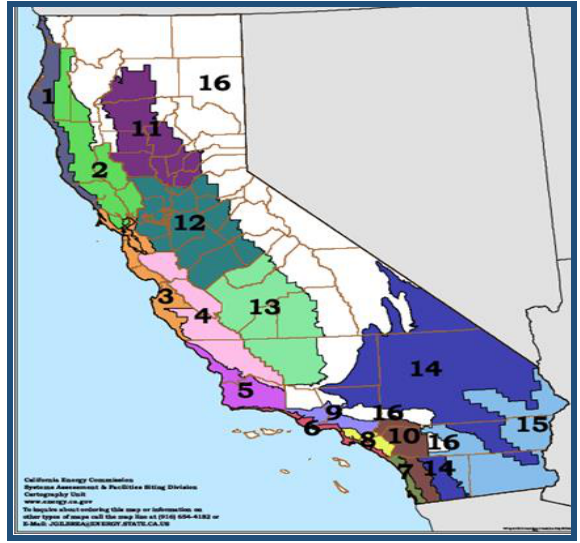
Figure 3. Map for the 16 climate zones for California [45]. Table 2. Summary of annual heating and cooling degree days for 16 locations representative of Cal- ifornia climate zones based on 18 °C (65 °F).